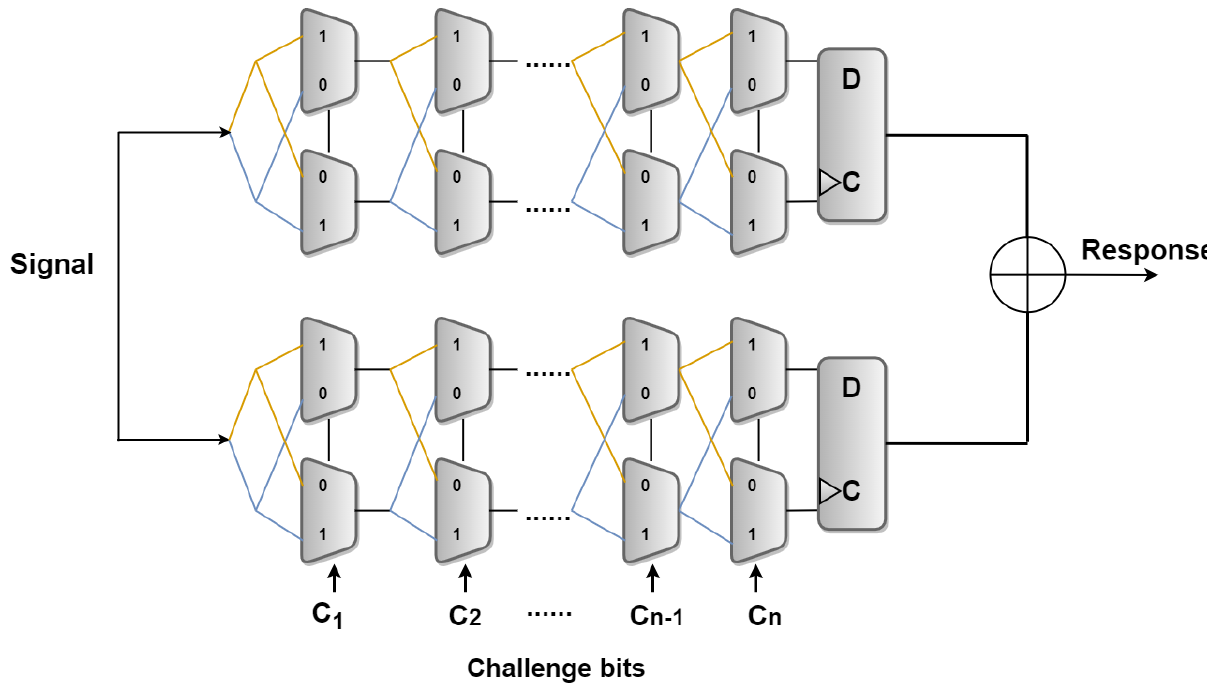
Figure 2. Illustration of an XOR-PUF with two arbiter PUF components and n bits of each stream; the final response is determined by the XORed result of two arbiter PUF